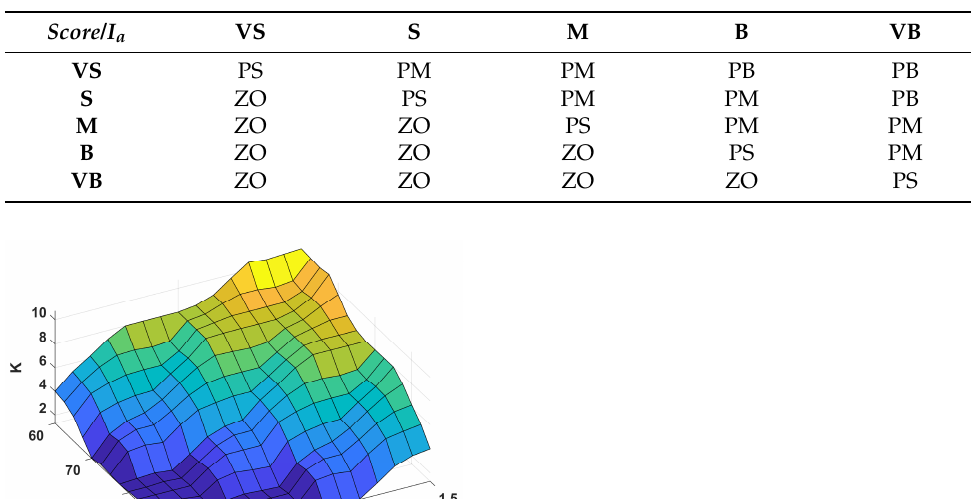
9 of 22 Figure 5. Fuzzy inference system structure diagram.